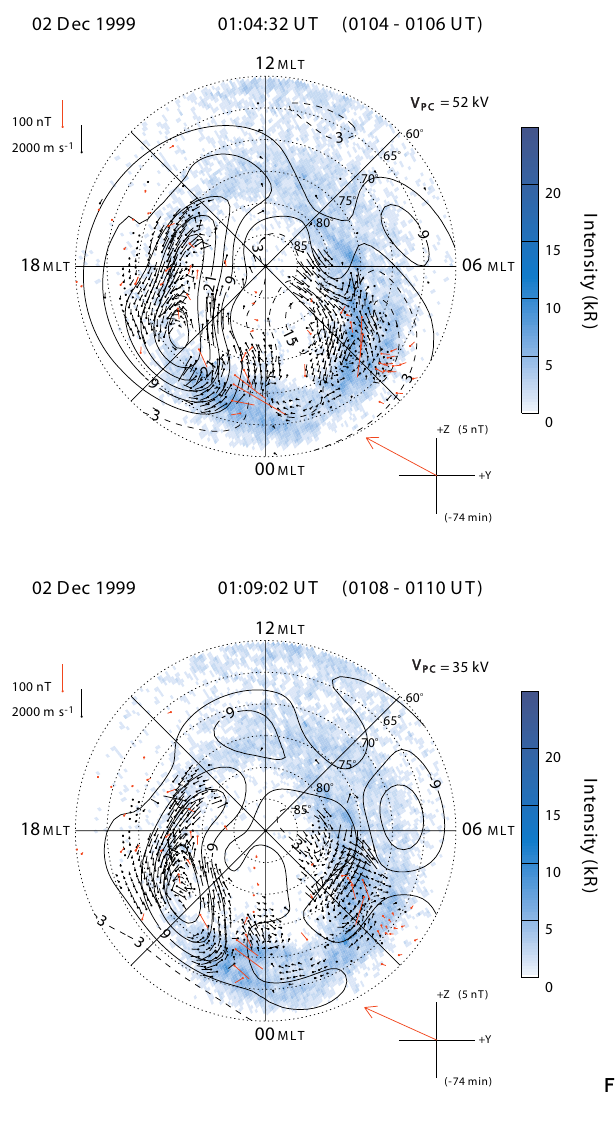
Fig. 7. Maps of the UV auroral lu- minosity projected onto a geomagnetic grid are shown spanning the same in- terval as in Fig. 6. SuperDARN Map- Potential streamlines and flow vectors are superposed. Magnetic data, shown in red, are horizontal magnetic pertur- bation vectors which have been rotated anti-clockwise through 90 ◦ to point in the direction of the E × B drift, as- suming they are due wholly to over- head Hall currents. Also indicated on the maps is the derived total transpolar voltage and the direction and magnitude (in the Y − Z plane) of the IMF, as in Fig. 6. The time indicated on each plot corresponds to the center time of the 32.5s integration interval of the UV im- age. The superposed SuperDARN and 2-min averaged magnetic vectors corre- spond to the interval shown in brackets, which encompasses the center time of Fig. 7d the UV